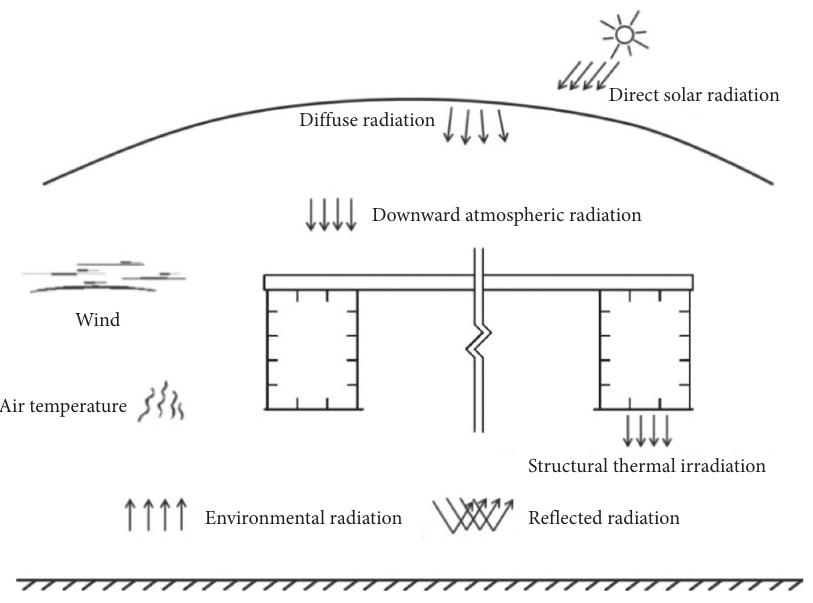
Figure 1: Thermal environments of a